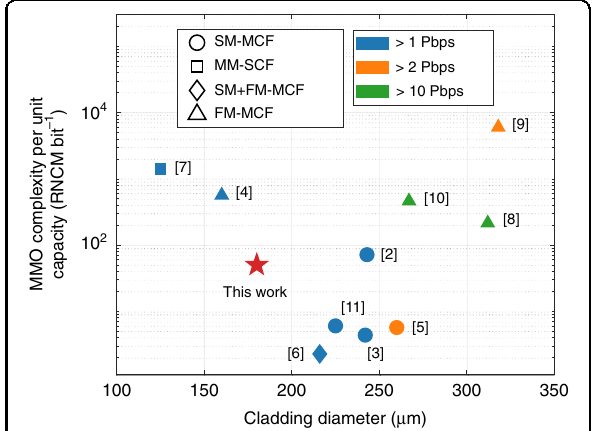
Fig. 1 MIMO complexity vs. cladding diametre. The data points are evaluated based on the information reported from the cited references that demonstrated over 1 Pbps capacity SDM